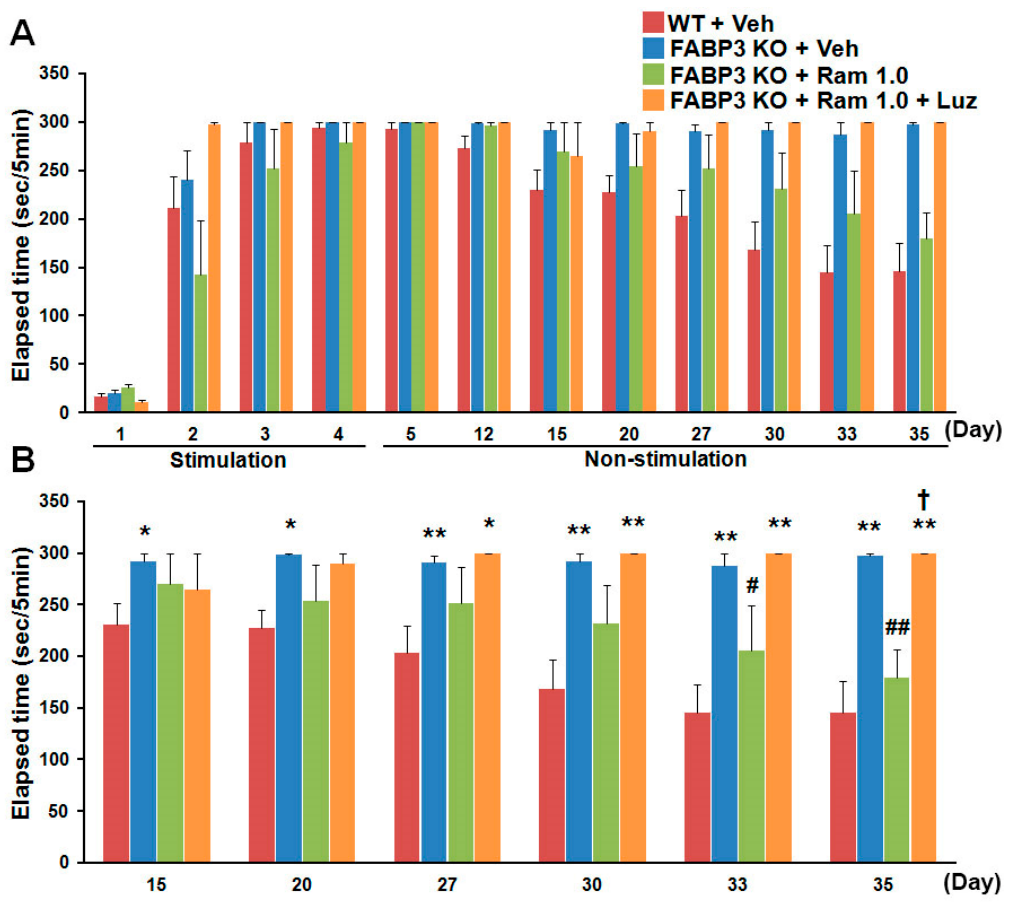
Figure 2. Impaired fear extinction processing in Fabp3 null mice. ( A ) Overview of fear responses as elapsed time during the acquisition (Day 1 to 4) and extinction phase (Day 5 to 35) ( n = 4–11 per group). ( B ) Ramelteon (1.0 mg/kg, p.o.) repaired the impaired fear extinction process in Fabp3 null mice from Day 15 to 35, an effect prevented by luzindole (2.5 mg/kg, i.p.) treatment ( n = 4–11 per group). Error bars represent SEM. * p < 0.05 vs. vehicle-treated wild-type (WT) mice; ** p < 0.01 vs. vehicle-treated WT mice; # p < 0.05 vs. vehicle-treated Fabp3 null mice; ## p < 0.01 vs. vehicle-treated Fabp3 null mice; † p < 0.05 vs. ramelteon (1.0 mg/kg, p.o.)-treated Fabp3 null mice. Luz, luzindole (2.5 mg/kg, i.p.) treatment; Ram 1.0, ramelteon (1.0 mg/kg, p.o.) treatment; veh, vehicle treatment. Modified data derived from Reference [156].